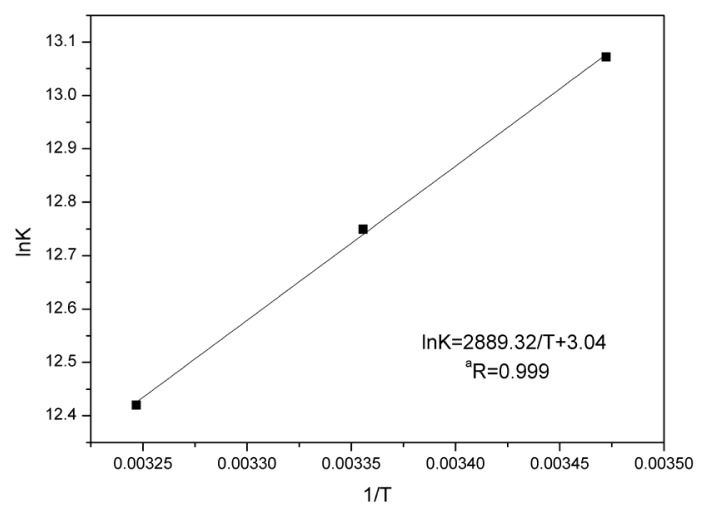
Van’t Hoff plot for the interaction between BSA and eupatorin (pH 7.4). CBSA = 3.0 × 10−7 M, pH 7.4; λex = 280 nm, λem = 290–500 nm.